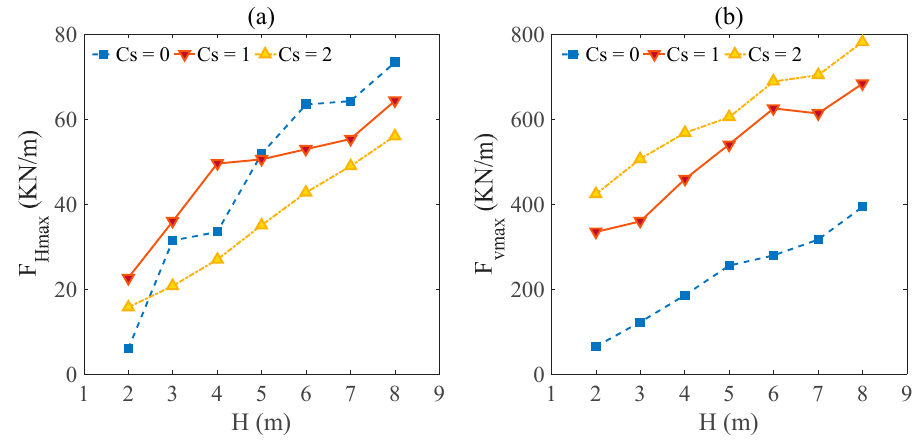
Figure 10. ( a ) Maximum horizontal force ( F H max ) and ( b ) Maximum uplift force ( F v max ) Maximum wave forces versus wave heights ( H ) for the case of box girder under three different submerged coefficients ( C s ).